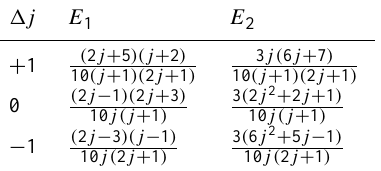
Table 1. E 1 and E 2 depend on the angular momentum j and the change of angular momentum (cid:49)j (from Chandrasekhar,